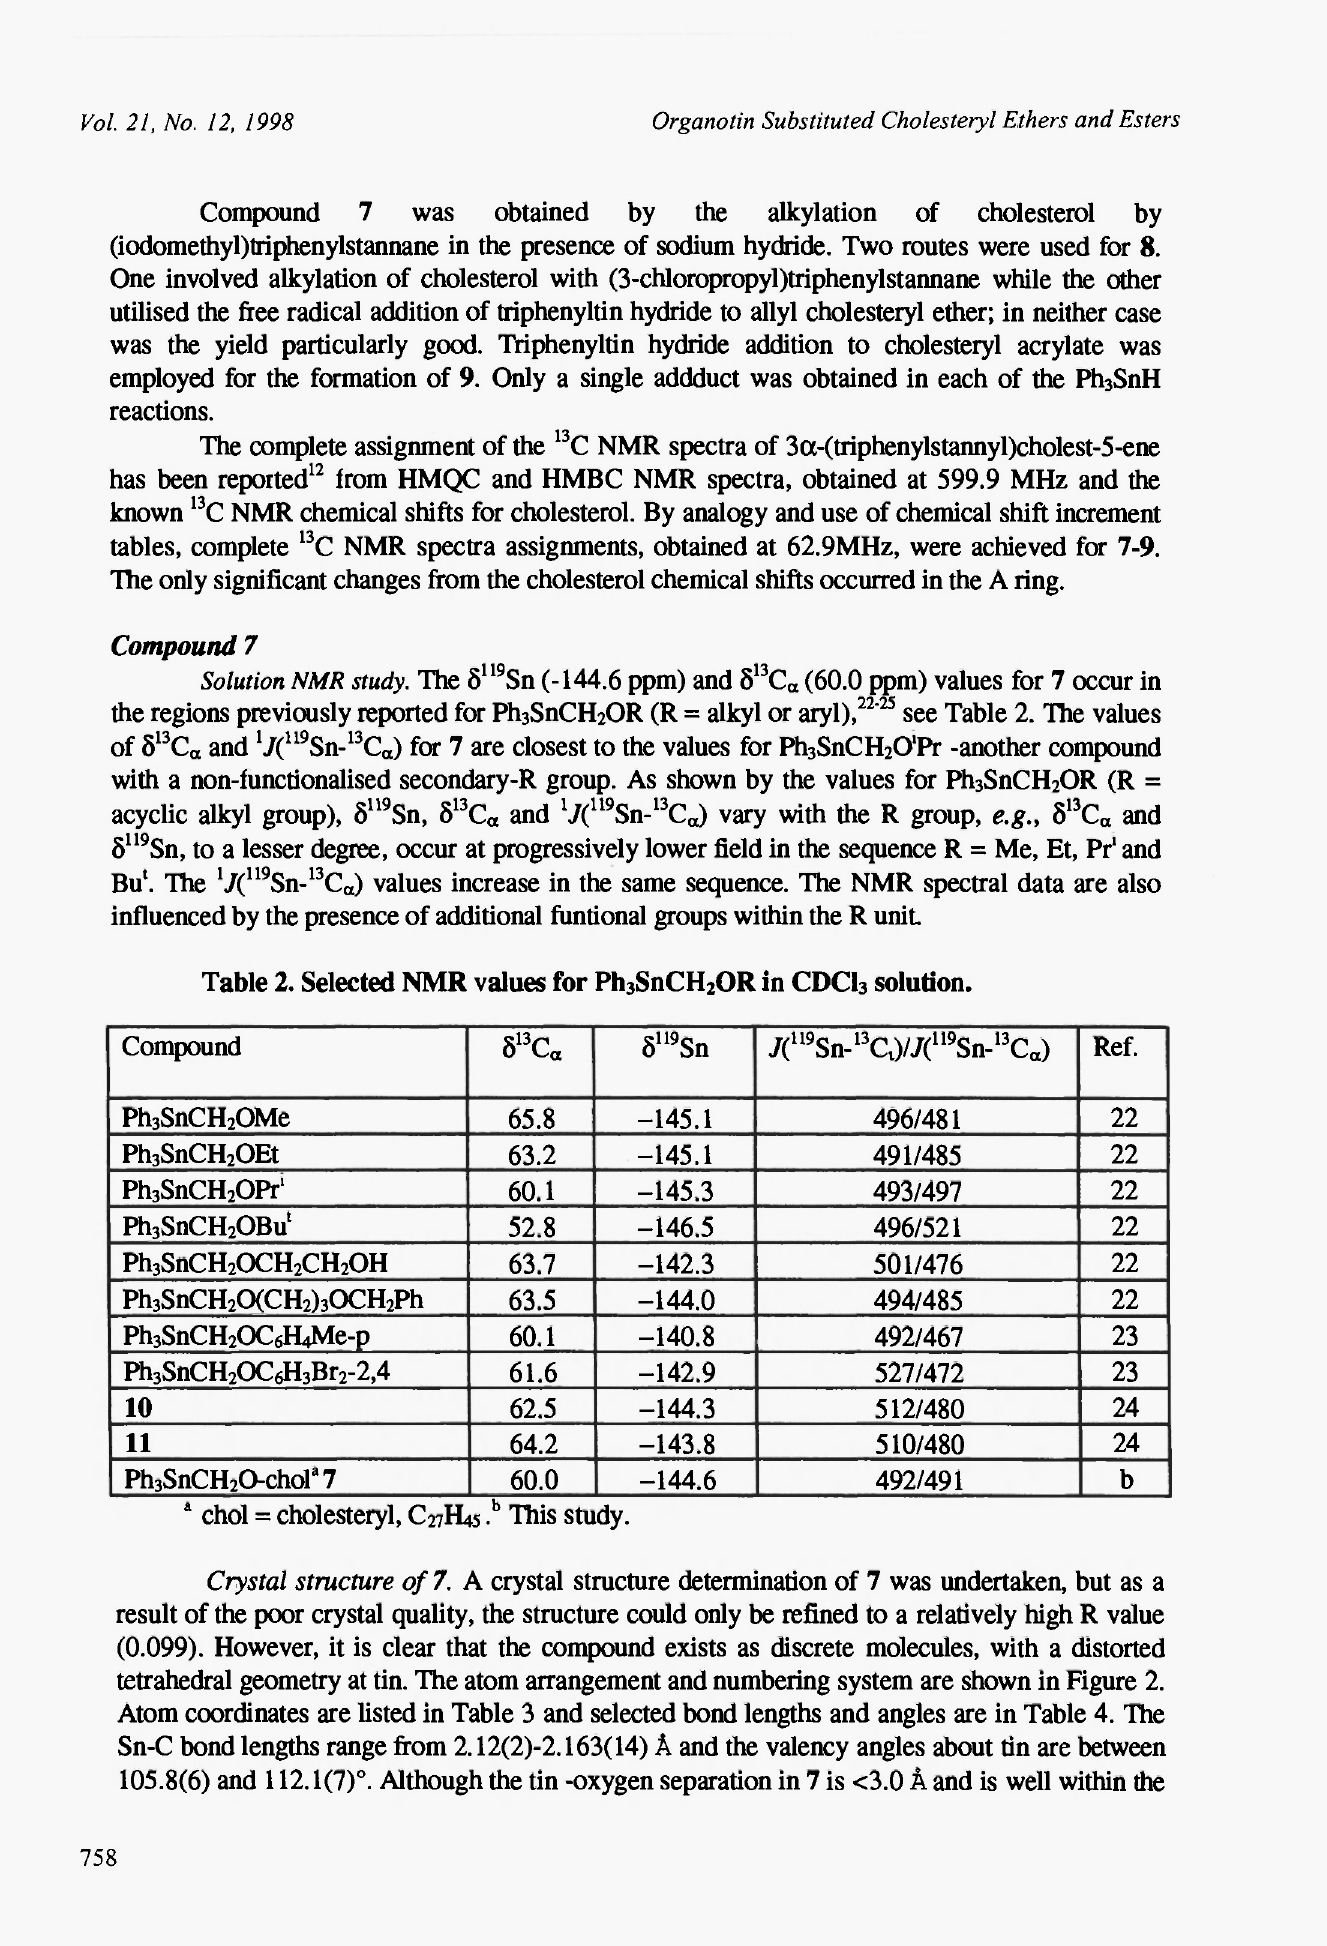
Table 2. Selected NMR values for Ph